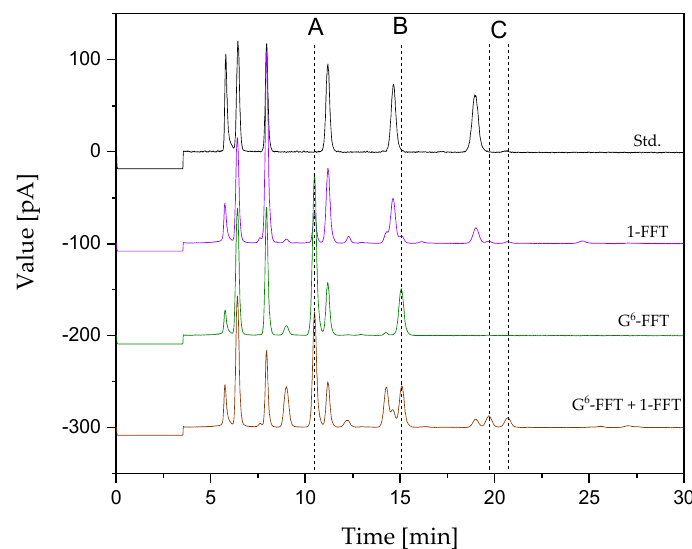
Figure 10. Chromatogram showing FOS standards and the two-step microscale production of neoFOS. Offset = 100 pA. The peaks correspond to ( A ) neokestose, ( B ) putative neonystose and ( C ) putative neoFOS with four fructose units (GF 4 ).